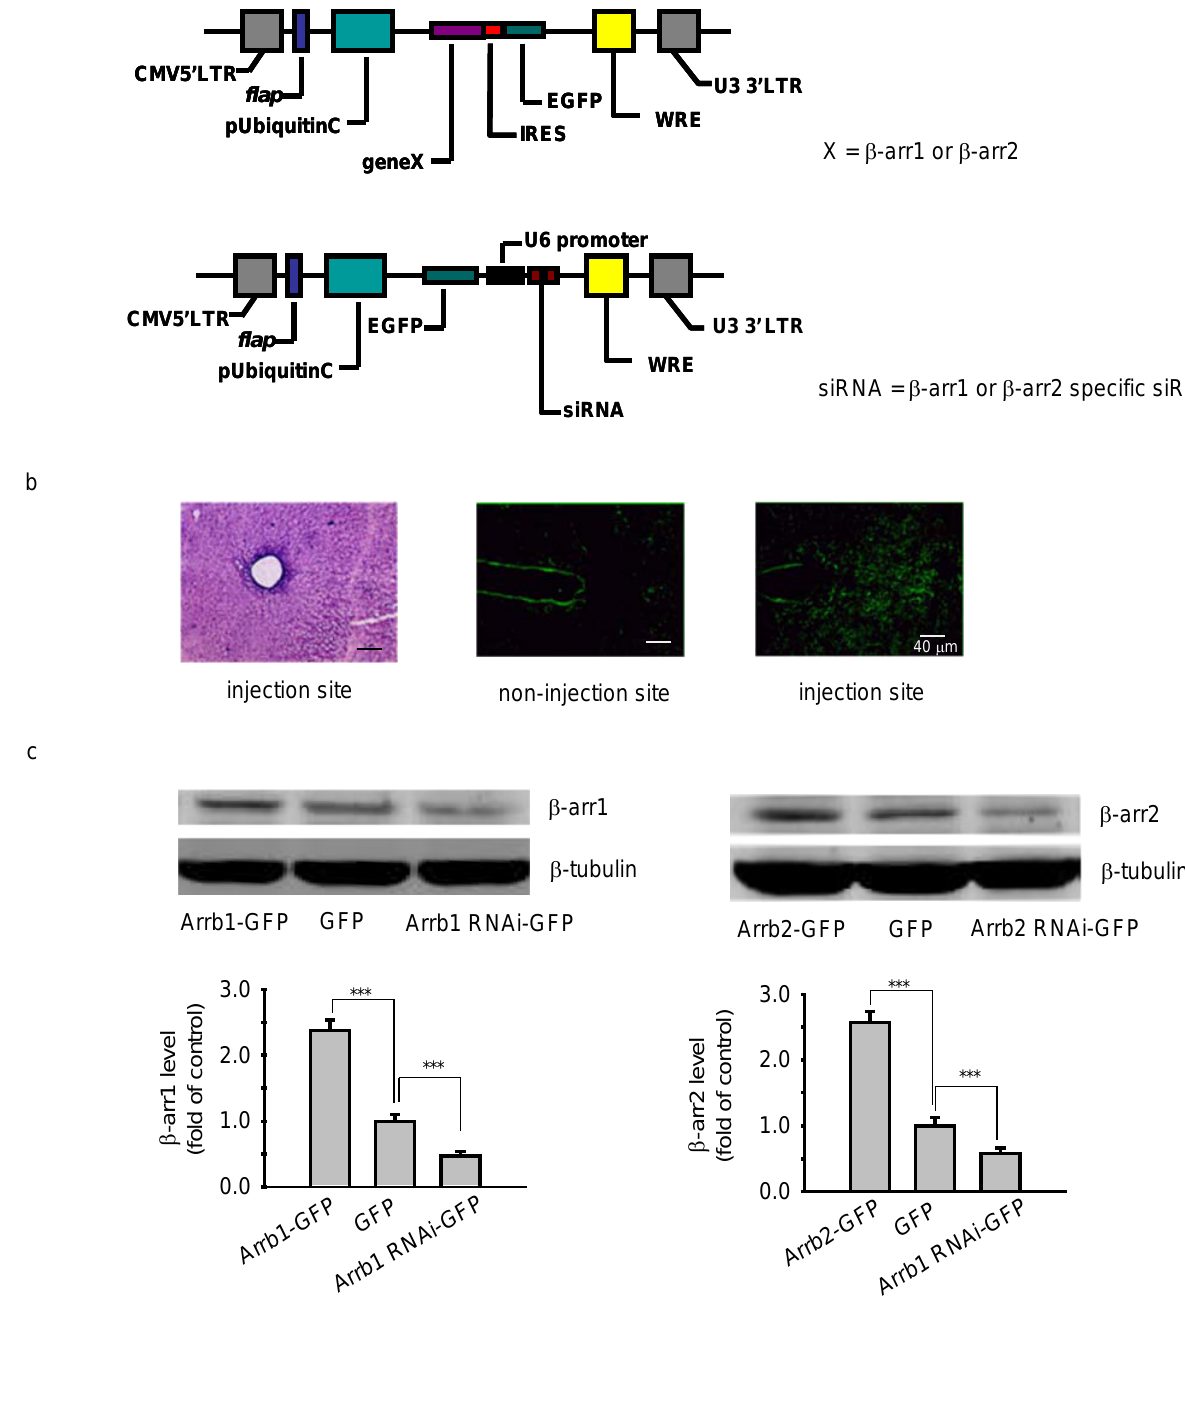
Figure 1. (a) Map of β -arrestin recombinant lentivirus generated by FUGW vector. (b) HE stain (left) and confocal images of the non-injection (middle) and injection site (right) in the PAG taken from an animal microinjected with the β -arrestin 2 lentivirus. And similar images of other lentiviruses used in the study were observed (data not shown). Green, GFP. Scale bar: 40 μ m. (c) Immunoblot analysis of β -arrestin protein levels in the microinjection sites. β -arr1, β -arrestin 1; β -arr2, β -arrestin 2. n = 3-4 mice of each group. ***p < 0.001 versus the GFP